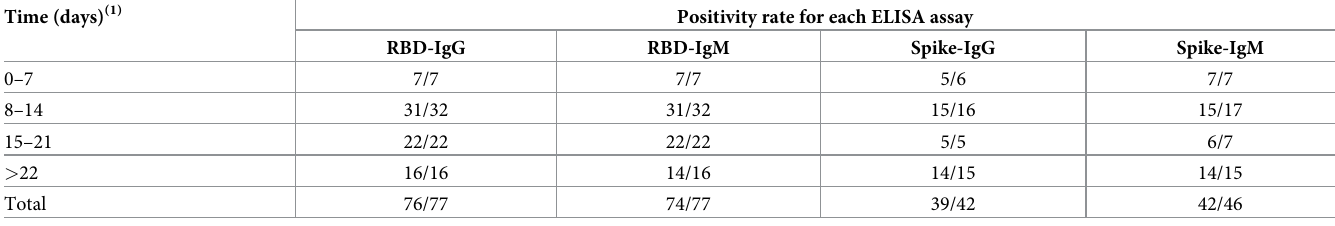
Table 3. Positivity rate by time in COVID-19